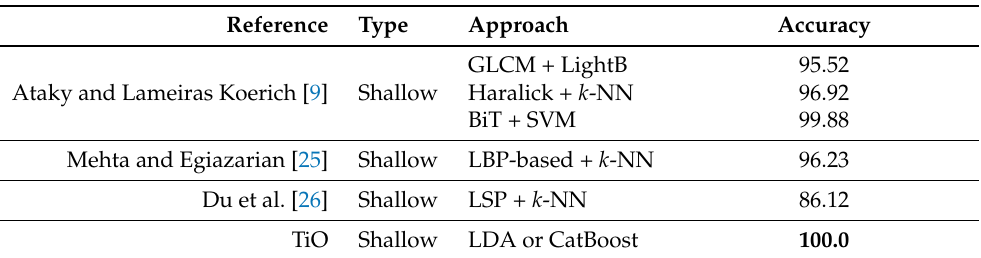
Table 3. Accuracy (%) of the proposed method and related works on the Outex dataset. The best result is shown in boldface.